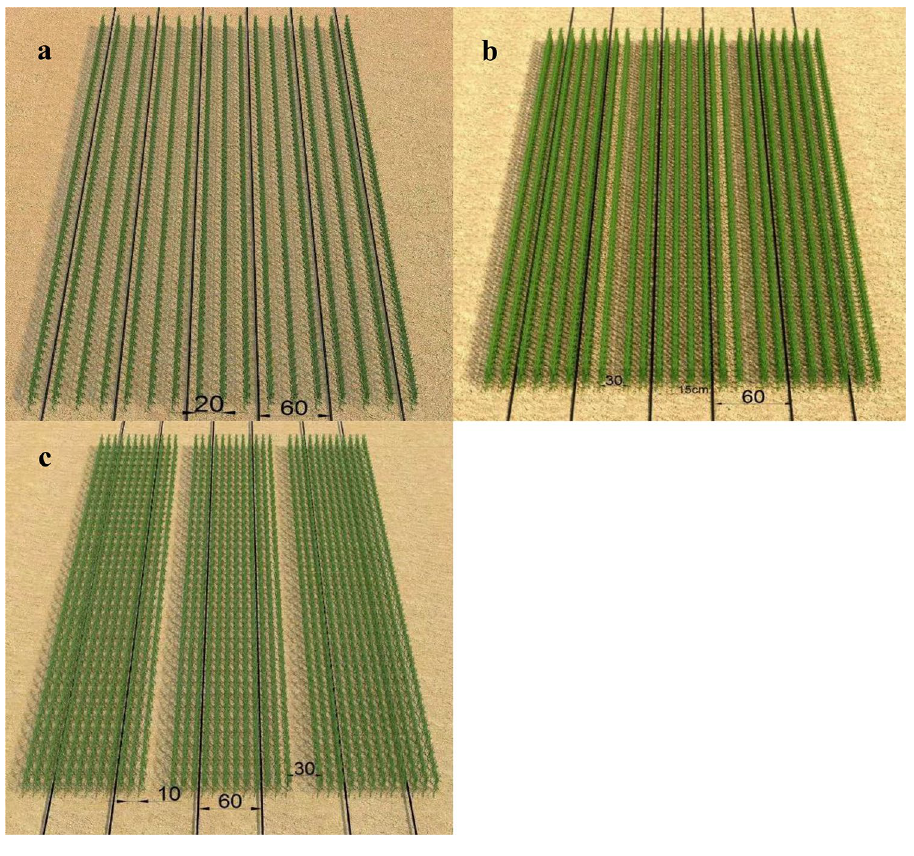
Figure 2. Planting patterns and drip tapes